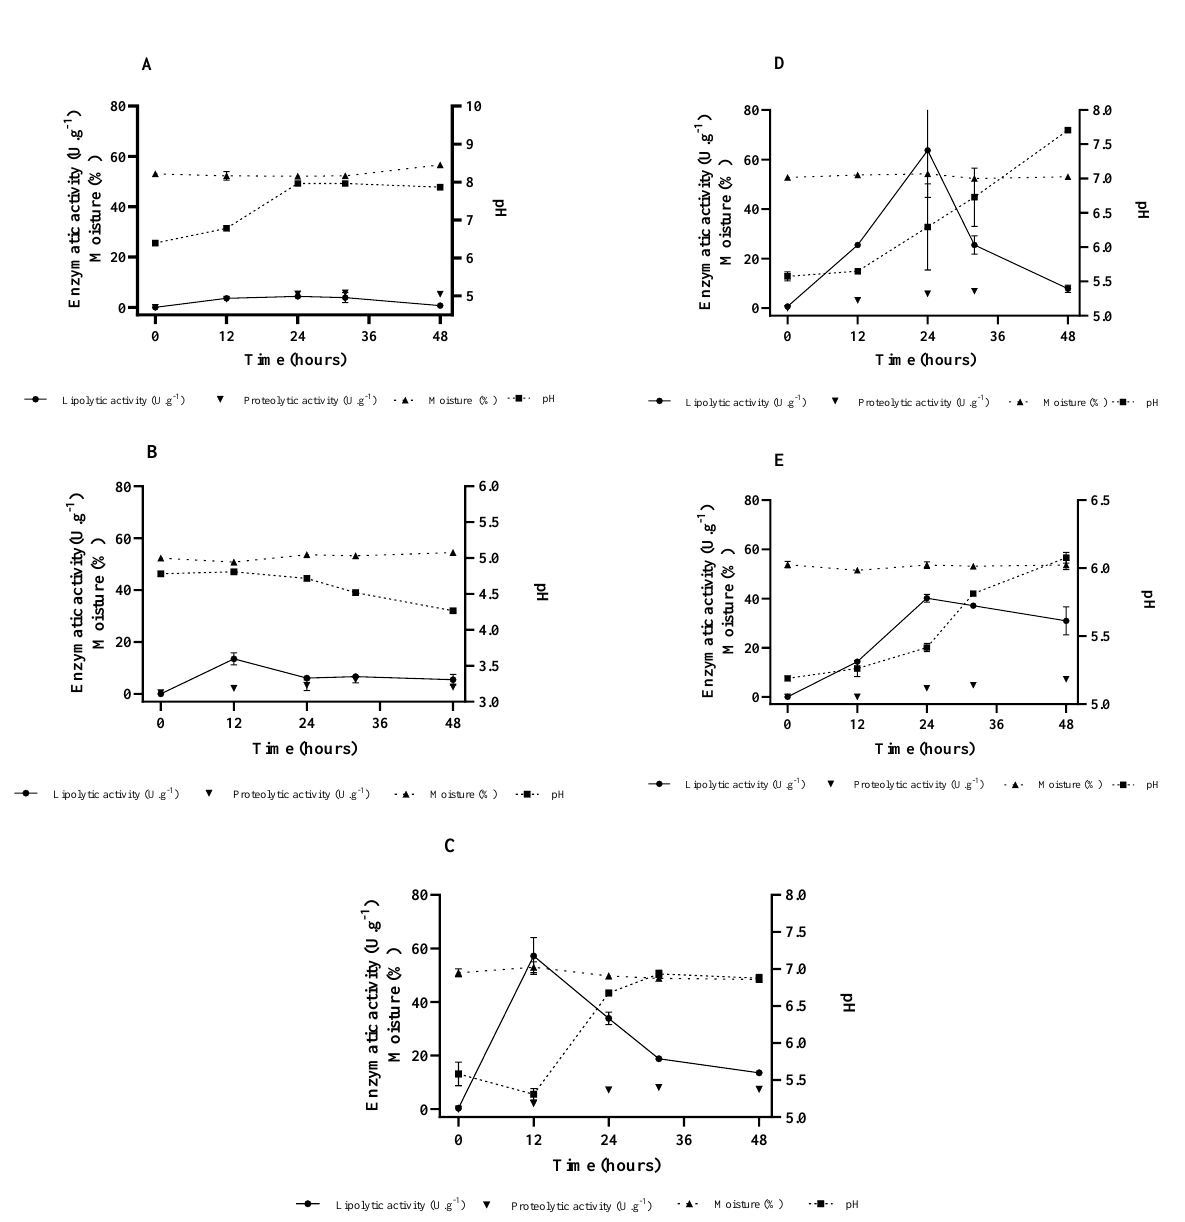
Figure 2. Screening of the matrices for the production of lipase in solid-state fermentation by Yarrowia lipolytica . ( A ) (0:100), ( B ) (100:0), ( C ) (25:75), ( D ) (50:50), and ( E ) (75:25). The proportion presented refers to the concentration of andiroba oil cake and soybean meal, respectively (andiroba:soy- bean).